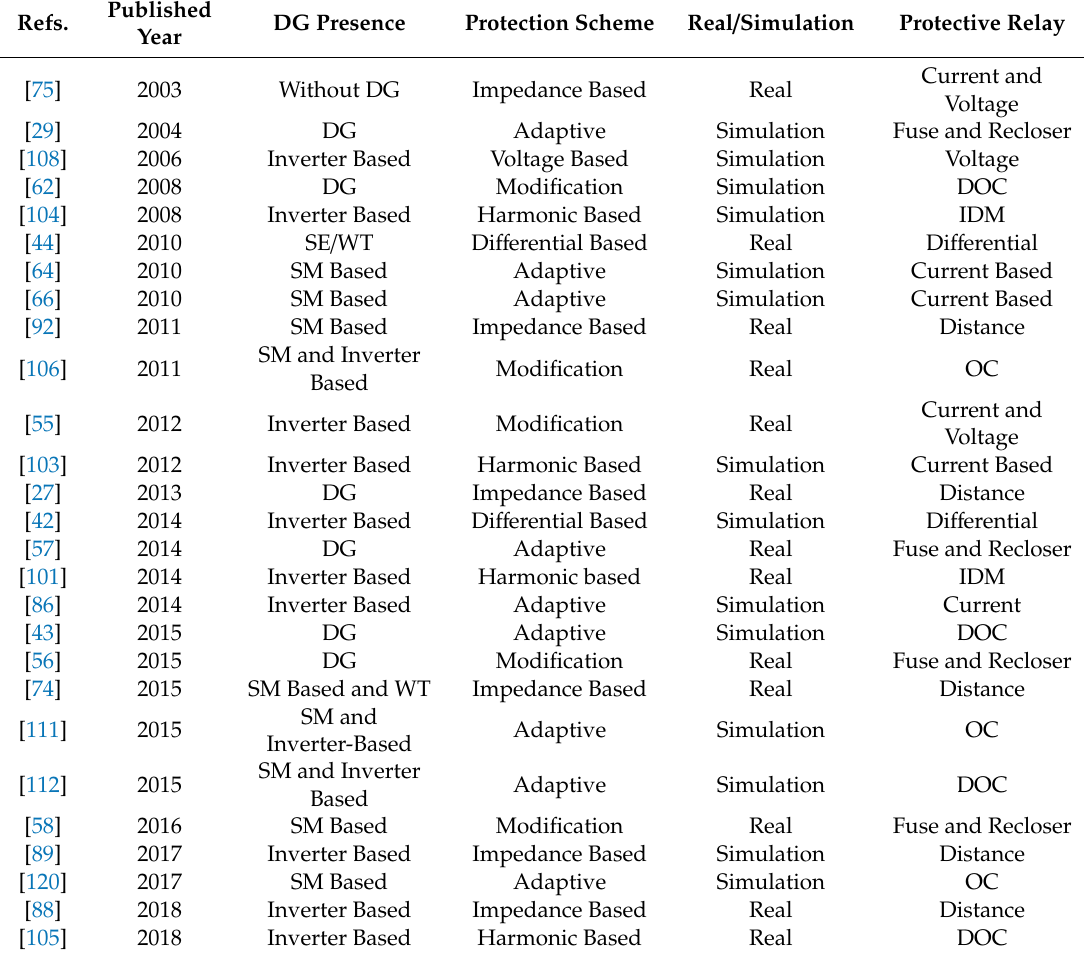
Table 1. Classification of di ff erent items used in microgrid protection schemes in the literature.